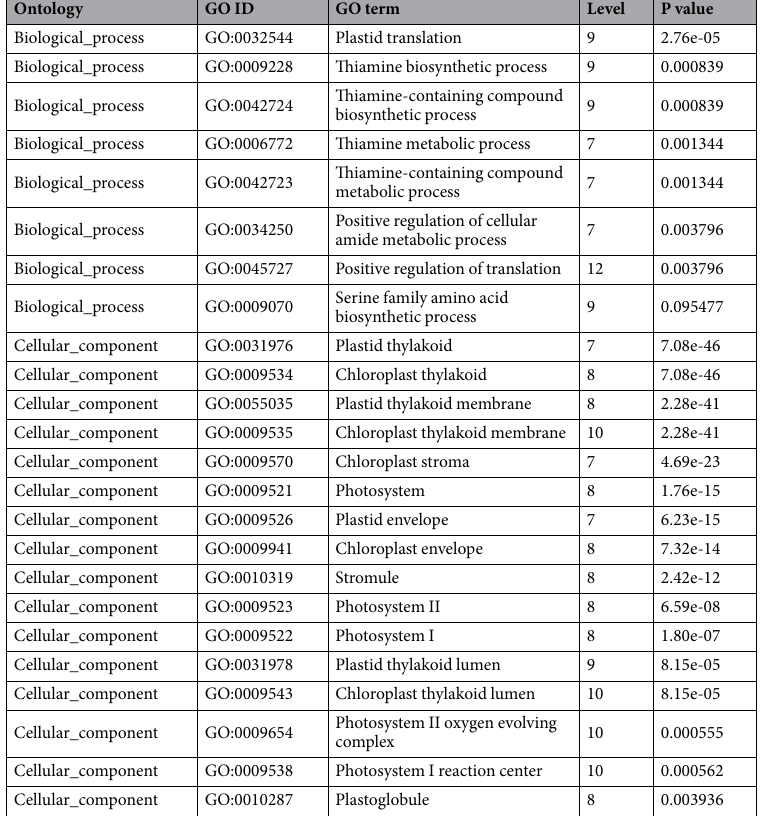
and PMPS involved in thiamin synthesis in A. stolonifera under drought and heat stress indicated the significance of thiamin in regulating plant responses to both heat and drought stress in perennial grass species.